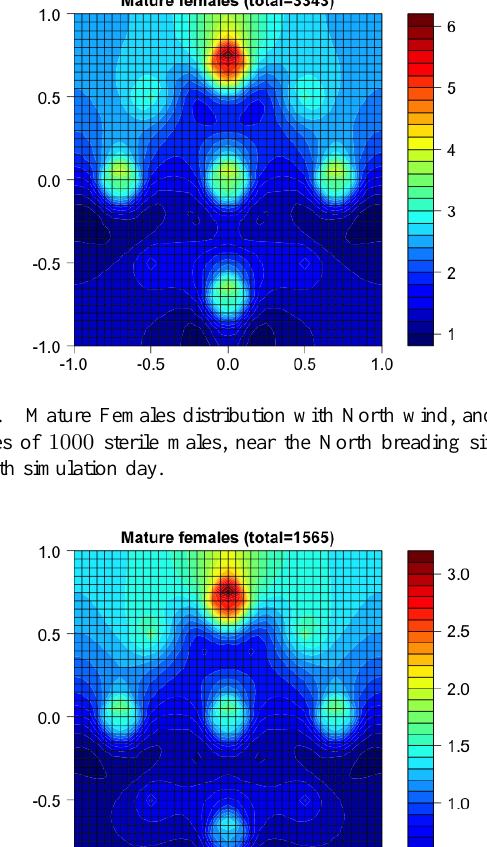
Mature Females distribution with North wind, mechanical control and releases of 1000 sterile males per week, from the 20th simulation day.